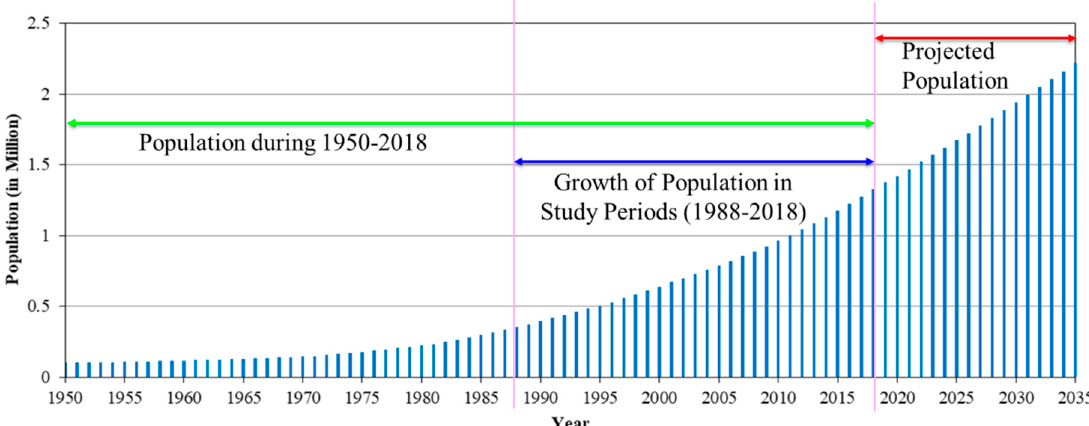
Figure A5. Population of Kathmandu City (1950–2035), Source: World Urbanization Prospects: The 2018 Revision by United Nation in 2018.